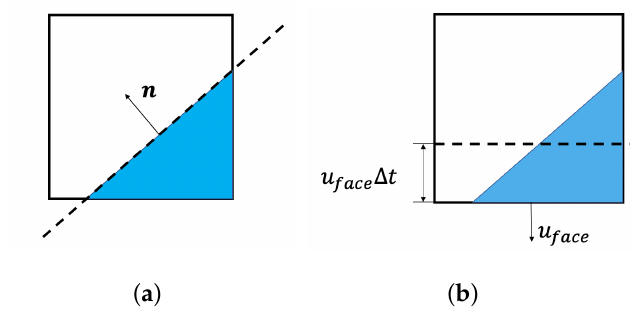
Figure 1. The interface reconstruction and flux calculation used in the Piecewise Linear Interface Calculation (PLIC) method.The region in blue is occupied by heavy fluid and the region in white is occupied by light fluid. The dotted line represents linearized interface in a cell. The black arrow in ( a ) indicates the normal vector of the interface and the black arrow in ( b ) indicates the direction of the velocity on that cell face. ( a ) Interface reconstruction. ( b ) Flux